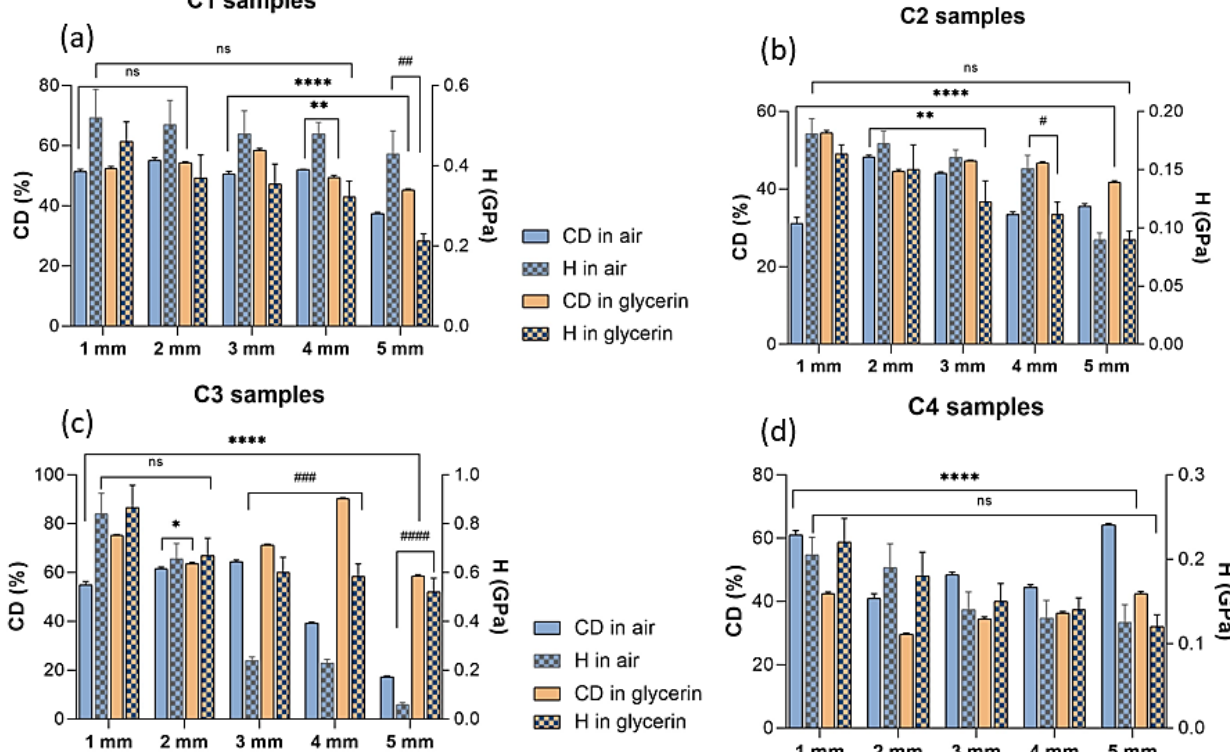
Figure 5. Impact of the light-curing distance on crosslinking degree (statistical significance: ns > 0.5; * p < 0.5; ** p < 0.005; **** p < 0.0001) and hardness (ns ˃ 0.5; # p < 0.5; ## p < 0.01; ### p < 0.001; #### p < 0.0001); ( a – d ) comparison of the same sample crosslinked in different environments — air